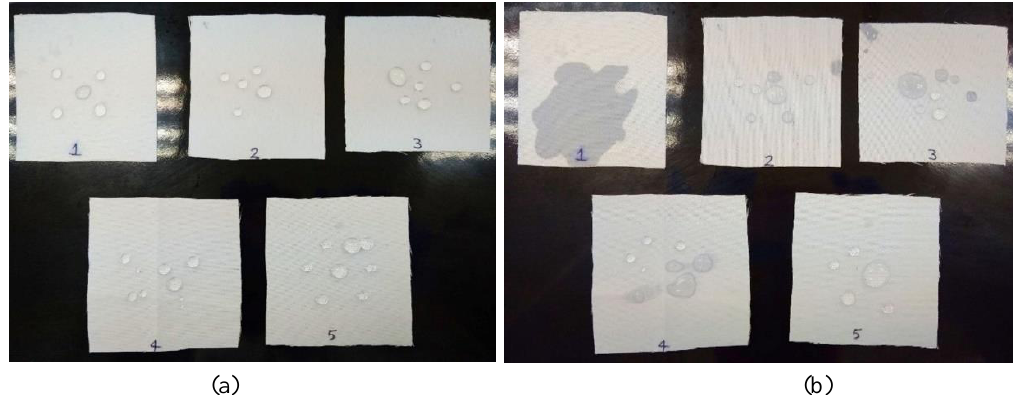
Figure 2. Polyester fabrics dipped with five different molar ratio of HTMS/H 2 O coating solutions (1) 1:40, (2) 1:30 , (3) 1:20, (4) 1:12 and (5) 1:3 after water dropping: (a) after a few seconds of water dropping; (b) after 30 minutes of water